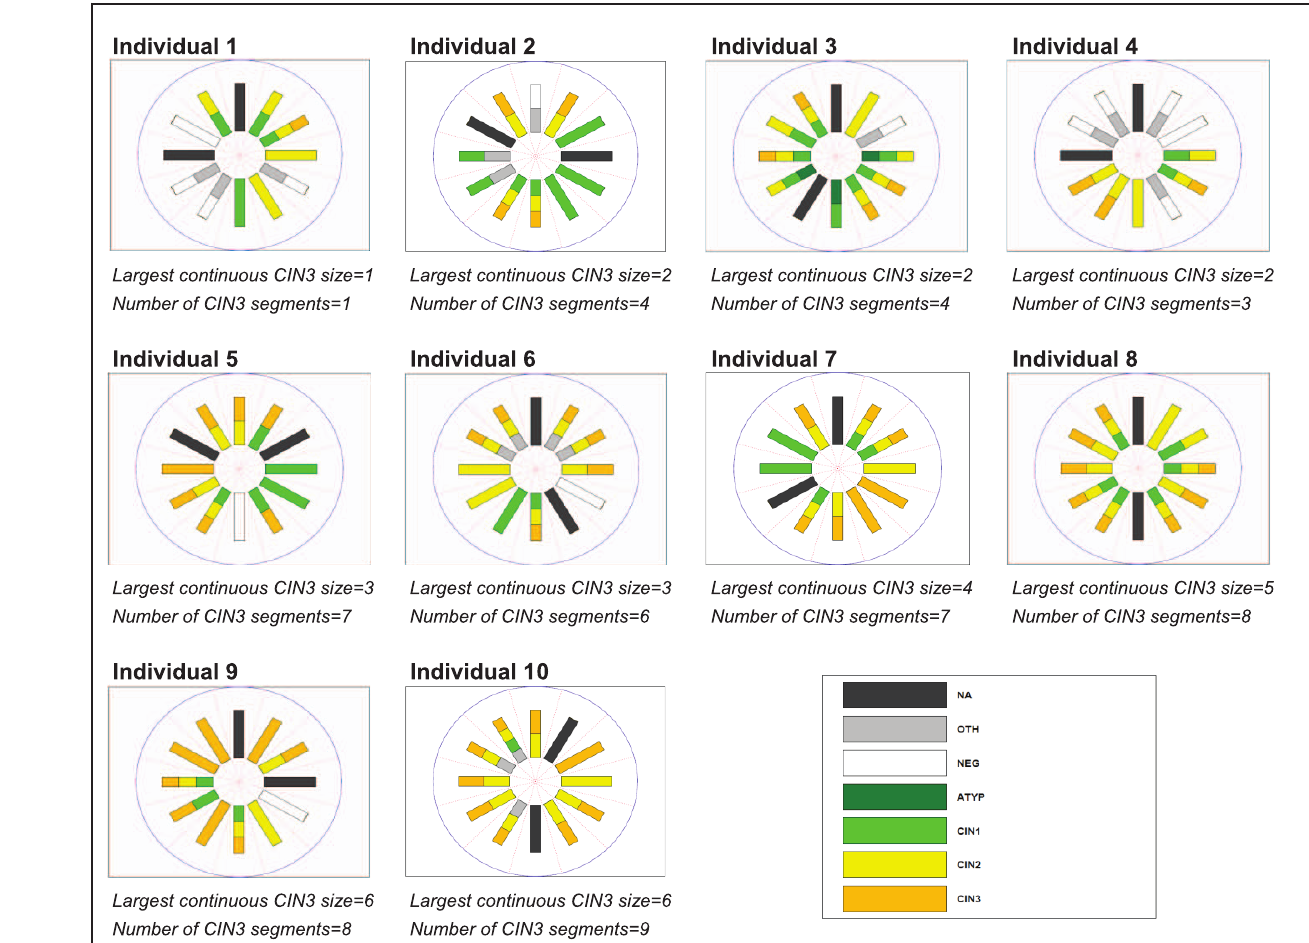
Figure 2. Sample of individual data for depicting the distribution of CIN LEEP segments among women in SUCCEED diagnosed as with CIN3 by LEEP.